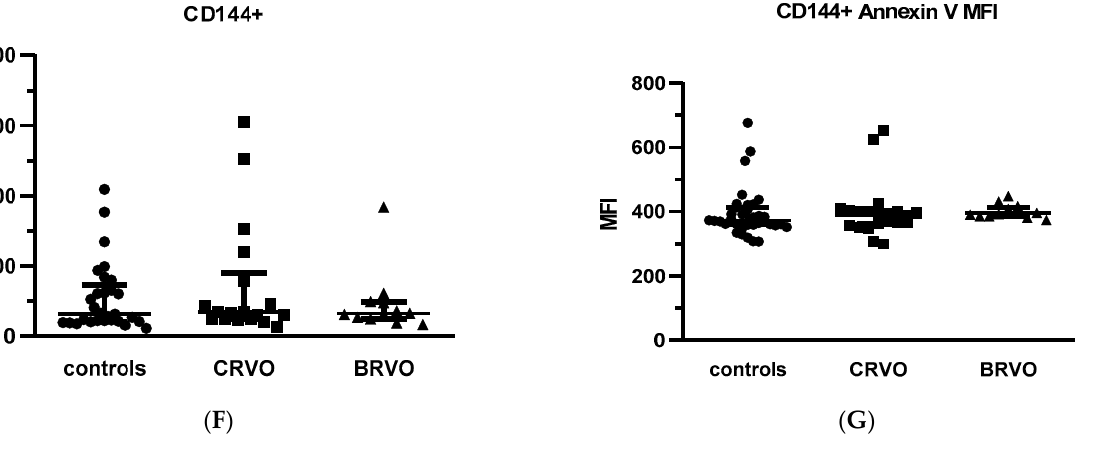
Figure 2. Both subtypes of RVO (CRVO and BRVO) are associated with increased number of procoagulant and platelet-derived microvesicles (MVs). The graphs present the dot-plots with median (horizontal bar) and interquartile range (Q1; Q3) (whiskers) of the antigen-positive MV populations, presented as densities, of procoagulant (annexin V-positive) ( A ), platelet-derived (CD41-positve) ( B ), leukocyte-derived (CD45-positive) ( D ), and endothelium-derived (CD144-positive) ( F ) MVs. Graphs ( C , E , G ) present the annexin V median florescence intensity (MFI) within the indicated antigen-specific MVs population. Significance of differences between BRVO vs. controls and CRVO vs. controls was estimated using the Kruskal–Wallis non-parametric test with Dunn’s multiple comparison test.